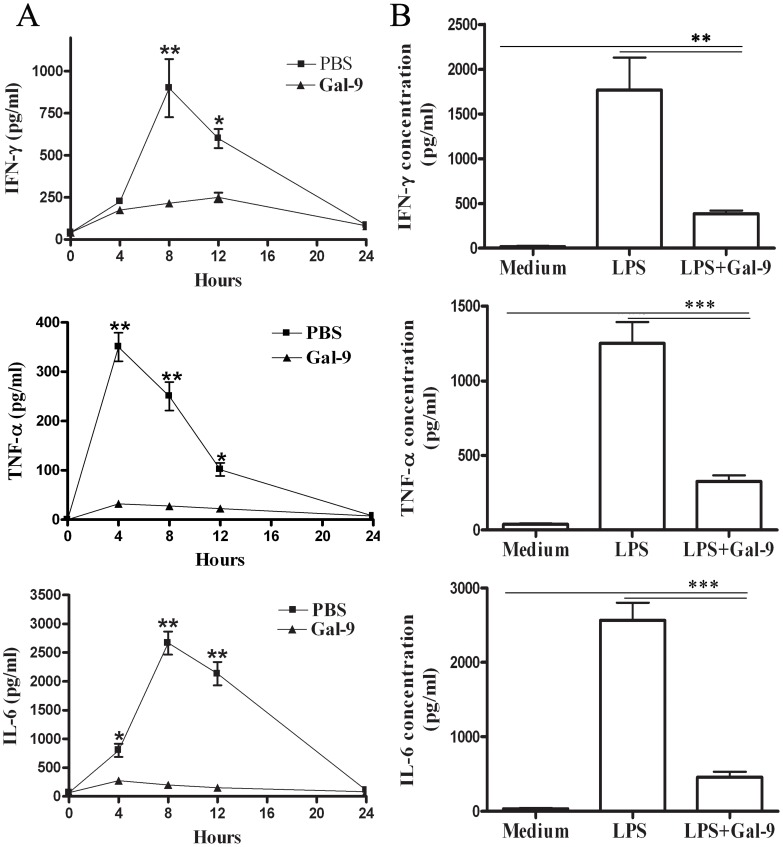
Effect of galectin-9 treatment on inflammatory cytokines secretion in vitro and in vivo.(A) Time course of IFN-γ, TNF-α and IL-6 release into serum after Con A injection, with or without galectin-9 (100 µg per mouse) administered i.v. for 30 minutes before Con A injection. Serum cytokine levels were determined using ELISA-assay kits. Data points represent the mean ± SD for 8 animals killed at each point. **, p<0.01; *, p<0.05 vs galectin-9 pretreated mice. (B) Spleen macrophages (1×106 cells/mL) were incubated for 24 hours with 100 ng/mL LPS, with or without galectin-9 treatment (10 µg/ml). Aliquots of supernatant were then collected and stored at −80°C until assayed. IFN-γ, TNF-α and IL-6 concentrations were measured by using specific ELISA kits. The results were presented as the mean ± SD of three separate experiments. ***, p<0.001; **, p<0.01.